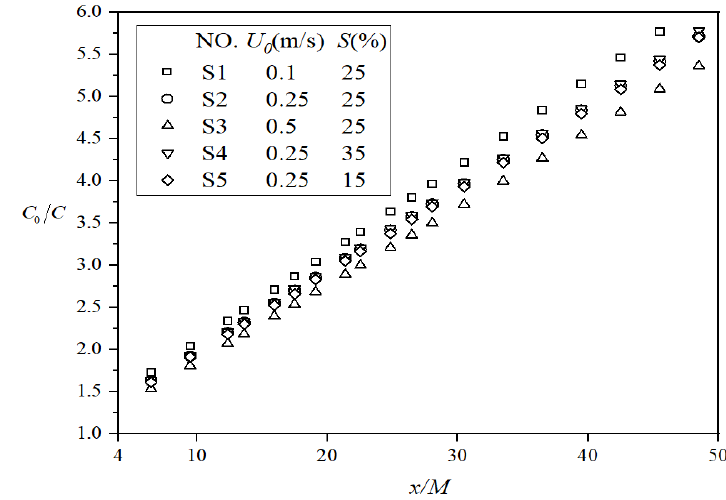
Figure 7. The scalar concentration decay C 0 / C at different downstream locations.